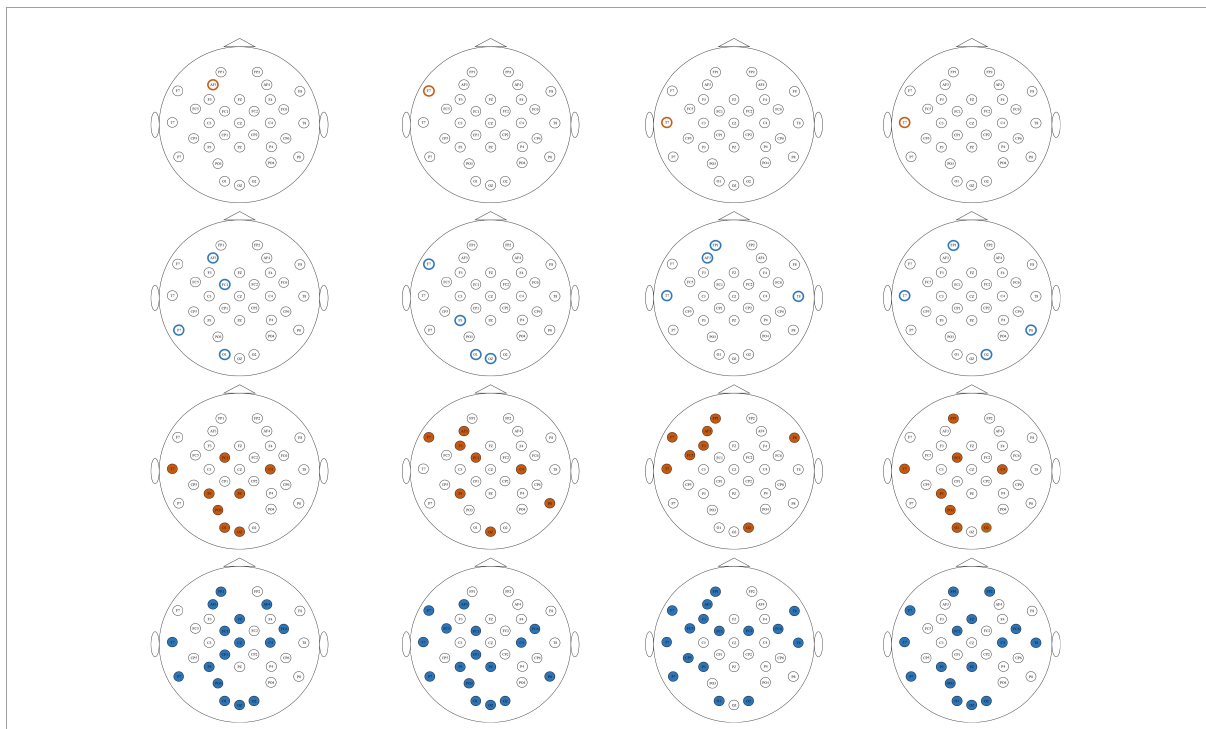
FIGURE7 The distribution of the most important 1, 4, 8, and 16 electrodes on the DEAP dataset. Brown circles mark the most important 1 electrode, blue circles mark the most important 4 electrodes, brown solid circles mark the most important 8 electrodes, and blue solid circles mark the most important 16 electrodes. From top to bottom, each row corresponds to first-order difference, second-order difference, high gamma band power, and high gamma band DE, respectively.